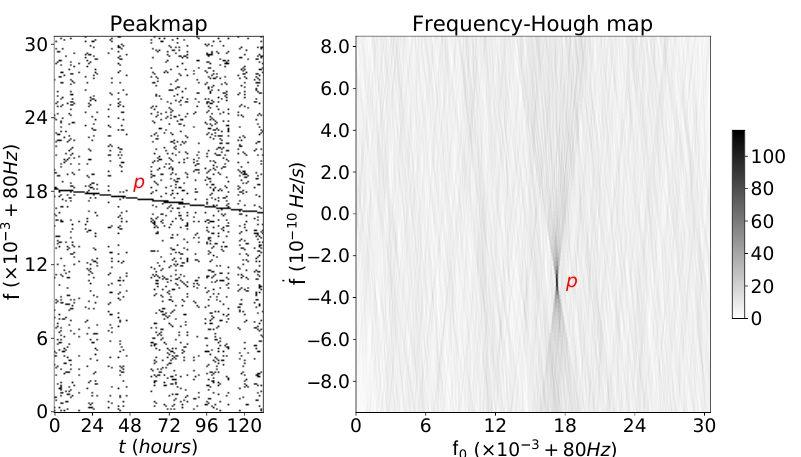
Figure 3. Example of a peakmap with real data (from LIGO Livingston O2 run [27]) and a straight line superimposed directly on the peakmap to naively simulate a pulsar signal with ref- erence frequency f 0 (cid:39) 80 Hz taken at mid time period of the peakmap, and spindown parameter ˙ f (cid:39) − 3.67 × 10 − 10